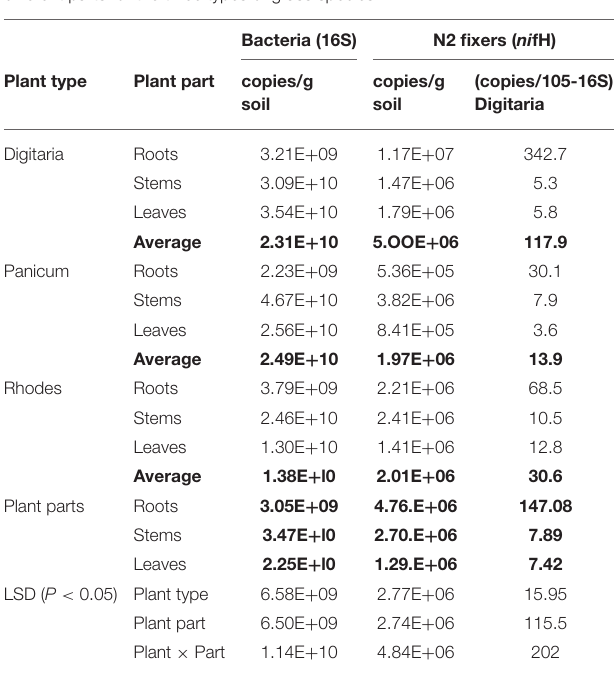
TABLE 1 | Abundance of total bacteria and N 2 -fixing ( nif H-harboring) bacteria in different parts for the three types of grass